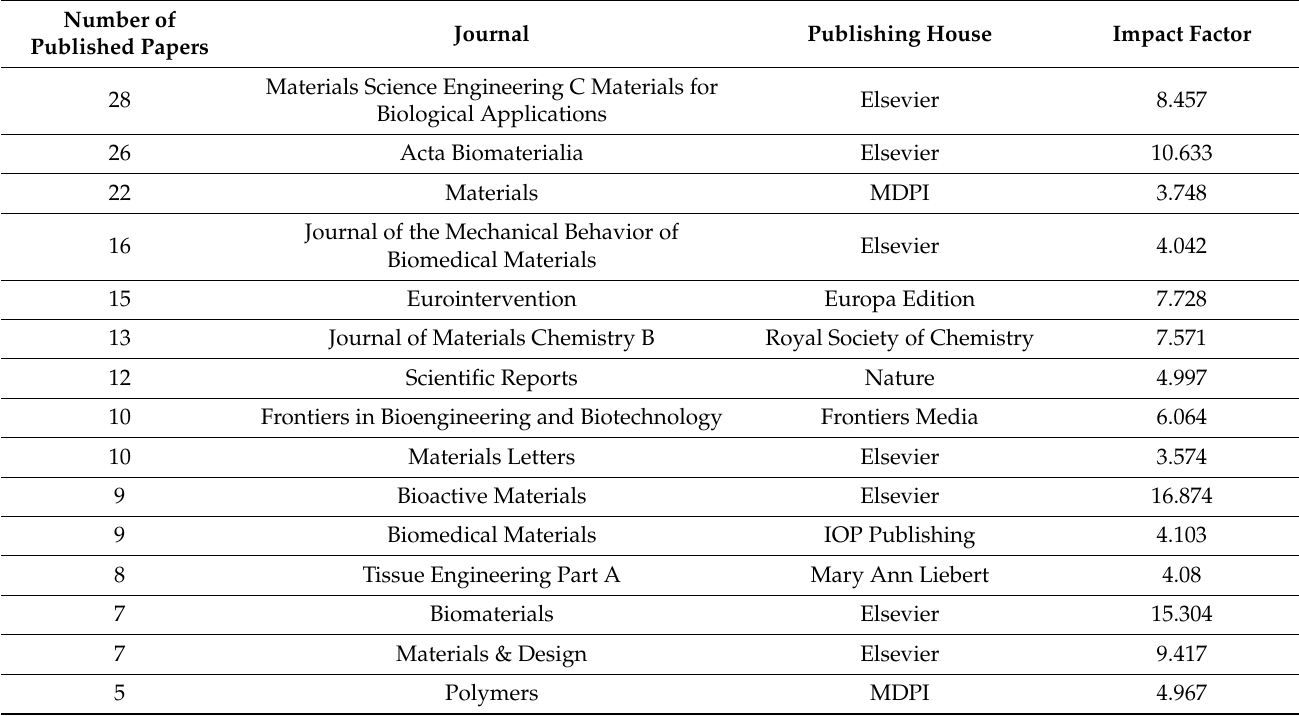
Table 2. Prestigious journals indexed in Web of Science Core Collection from 2013 − 2022 having papers on magnesium-based